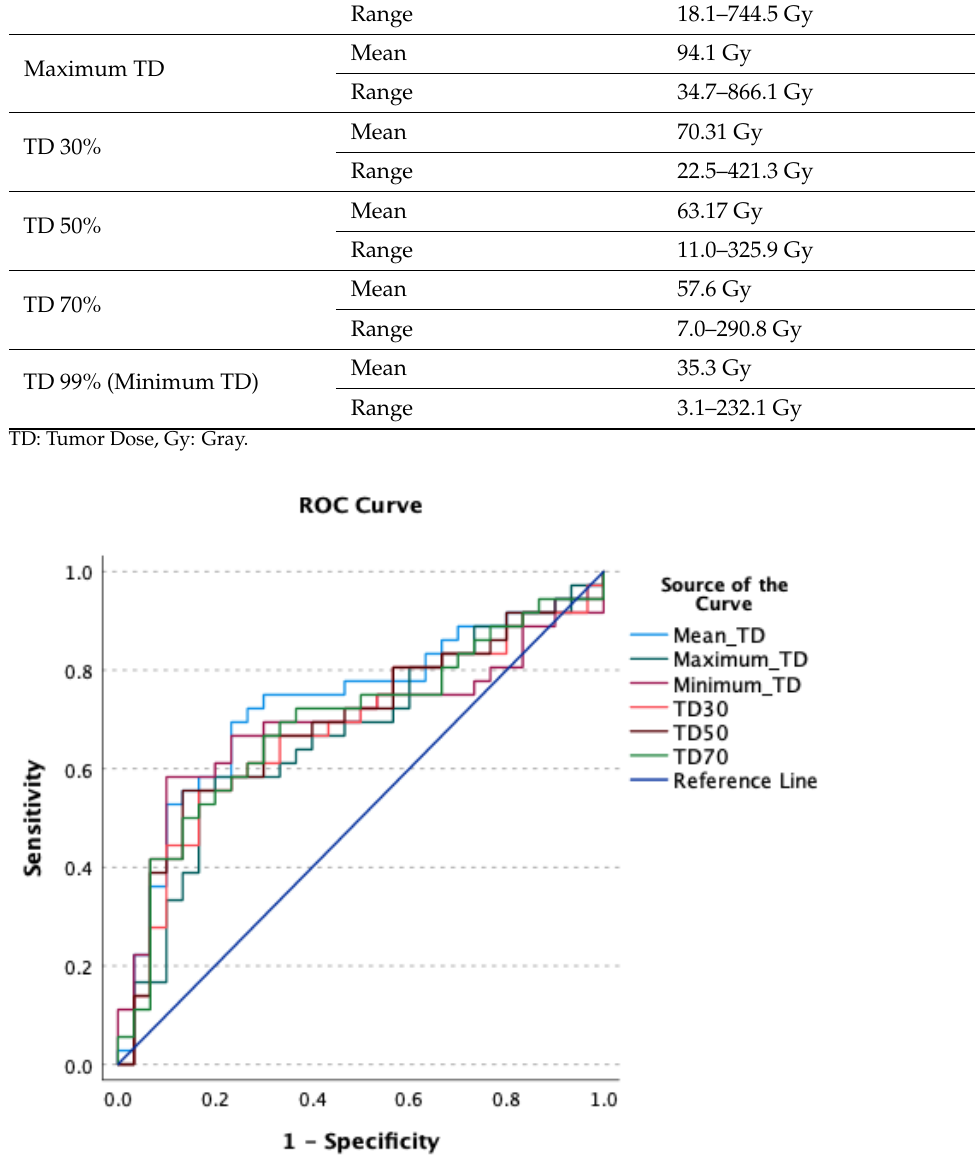
Figure 2. ROC Curve for dosimetry parameters predicting partial or complete response based on Response Evaluation Criteria in Solid Tumors with the following AUC’s: Mean TD (0.730), TD 30 (0.679), TD 50 (0.690), TD 70 (0.692), maximum TD (0.692), minimum TD (0.666).